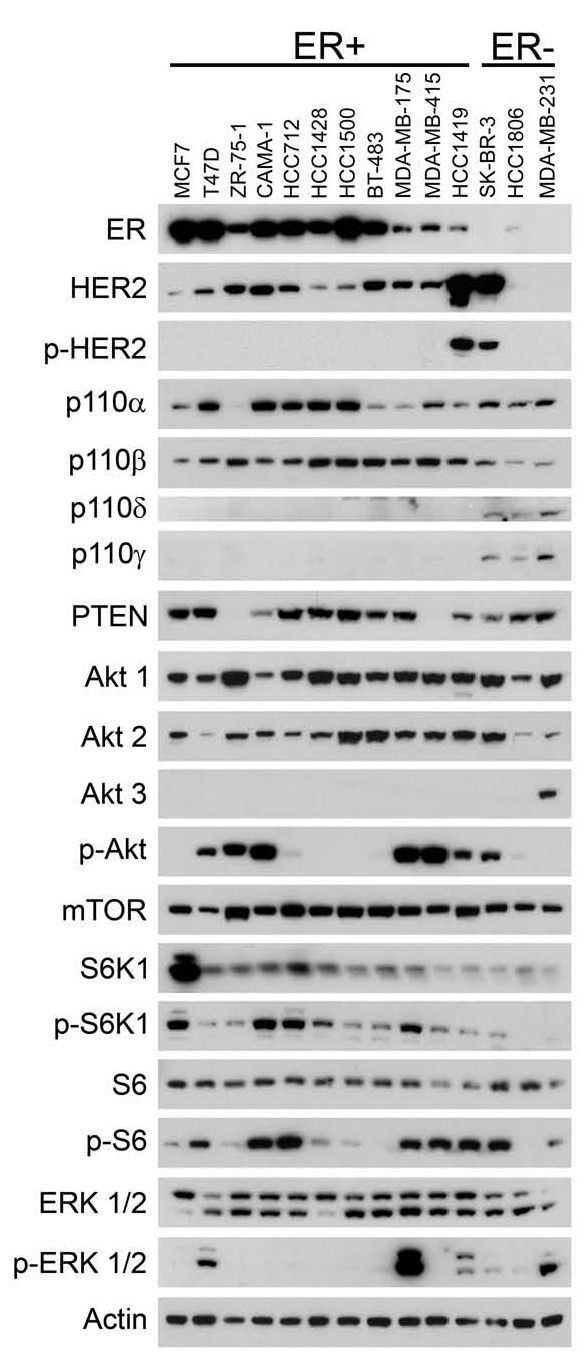
Analysis of phosphatidylinositol-3-kinase pathway signaling in breast cancer cells. Cell lines were grown to subconfluency and placed in medium containing low (0.5%) fetal bovine serum overnight prior to preparation of cell lysates. Equal amounts (25 μg) of extracted protein from each cell line were then immunoblotted using antibodies against the indicated proteins. P-Tyr1248 HER2 (p-HER2); p-Ser473 Akt (p-Akt); p-Thr389 S6 protein kinase 1 (p-S6K1); p-Ser235/236 S6 (p-S6); p-Thr202/Tyr204 ERK (p-ERK). ER, estrogen receptor; HER2, human epidermal growth factor receptor 2; PTEN, phosphatase and tensin homolog; mTOR, mammalian target of rapamycin.